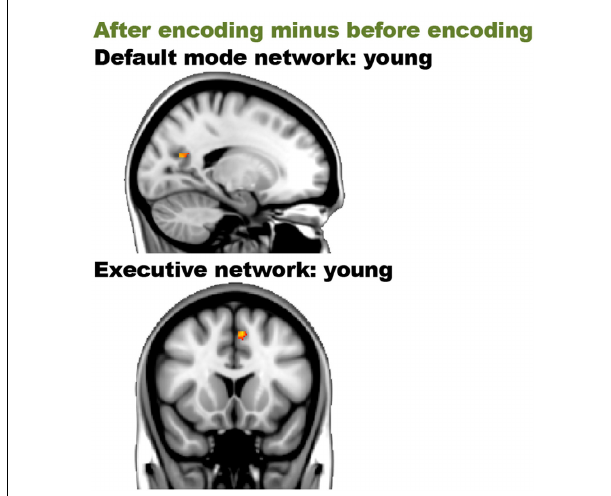
FIGURE 5 | Resting-state differences over time within young participations within the networks of interest. Within-network within-group effects were found for the contrast “after encoding minus before encoding” in young individuals. Red clusters indicate increased connectivity over time.